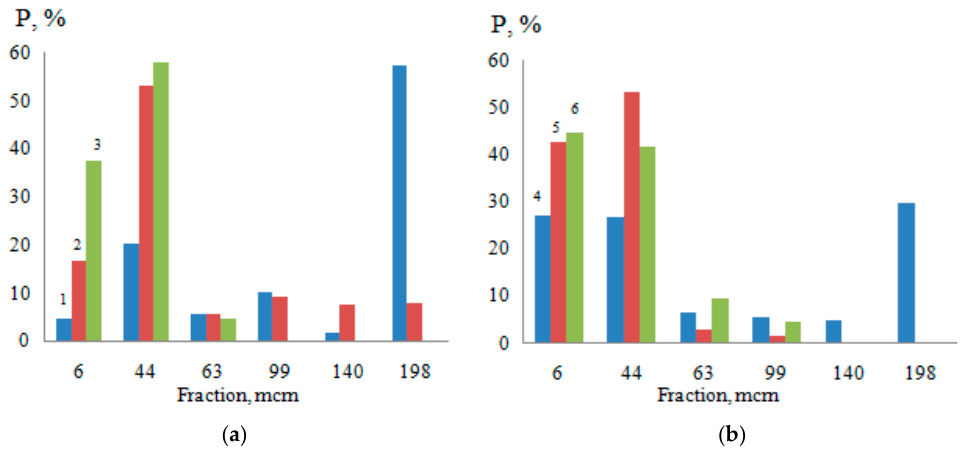
Figure 7. Distribution of titanium dioxide dispersions by size classes in water ( a ) and in a 10% film-forming solution ( b ) at CS = 0.5 g/dm 3 (1—H 2 O, 2—H 2 O + 0.5 g/dm 3 (PC), 3—H 2 O + 0.5 g/dm 3 (NaPA), 4—10%, 5—10% + 0.5g/dm 3 (PC), 6—10% + 0.5 g/dm 3 (NaPA)).